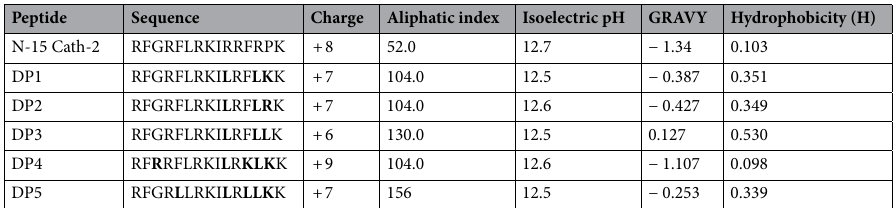
Table 1. Primary sequences and physiochemical properties of N-15 CATH-2 and its designed peptide analogs.